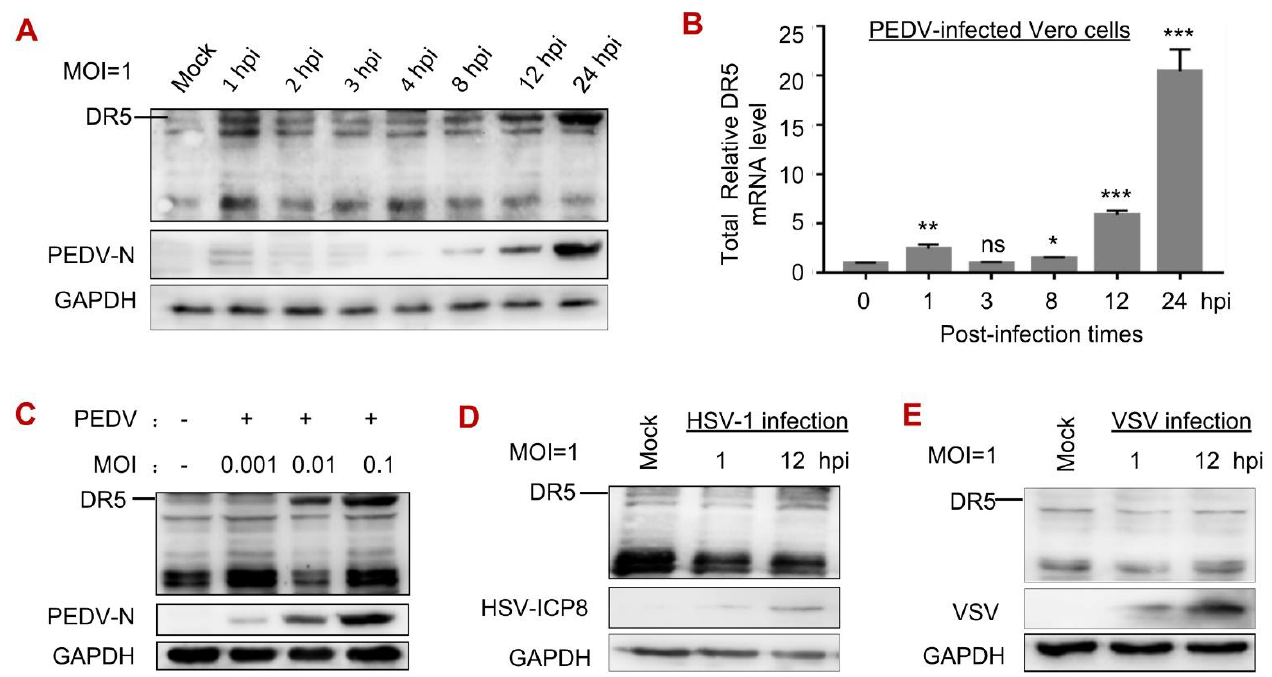
Figure 2. DR5 expression is upregulated by viral infection of PEDV but not HSV-1 or VSV. ( A , B ), Vero cells were mock infected or infected with PEDV at MOI of 1, cells were harvested at pointed time. The protein level was analyzed by Western blot with the indicated antibodies ( A ). The mRNA level was subjected to RT-qPCR analysis for DR5 ( B ). ( C ) Vero cells were mock infected or infected with PEDV at MOI of 0.001, 0.01, and 0.1. At 24 hpi, cells were harvested and the protein level was analyzed by Western blot with the indicated antibodies. ( D , E ) Vero cells were mock infected or infected with HSV-1 ( D ) or VSV ( E ) at MOI of 1. At 24 hpi, cells were harvested and the protein level was analyzed by Western blot with the indicated antibodies. *, p < 0.05; **, p < 0.01; ***, p < 0.001; ns p >